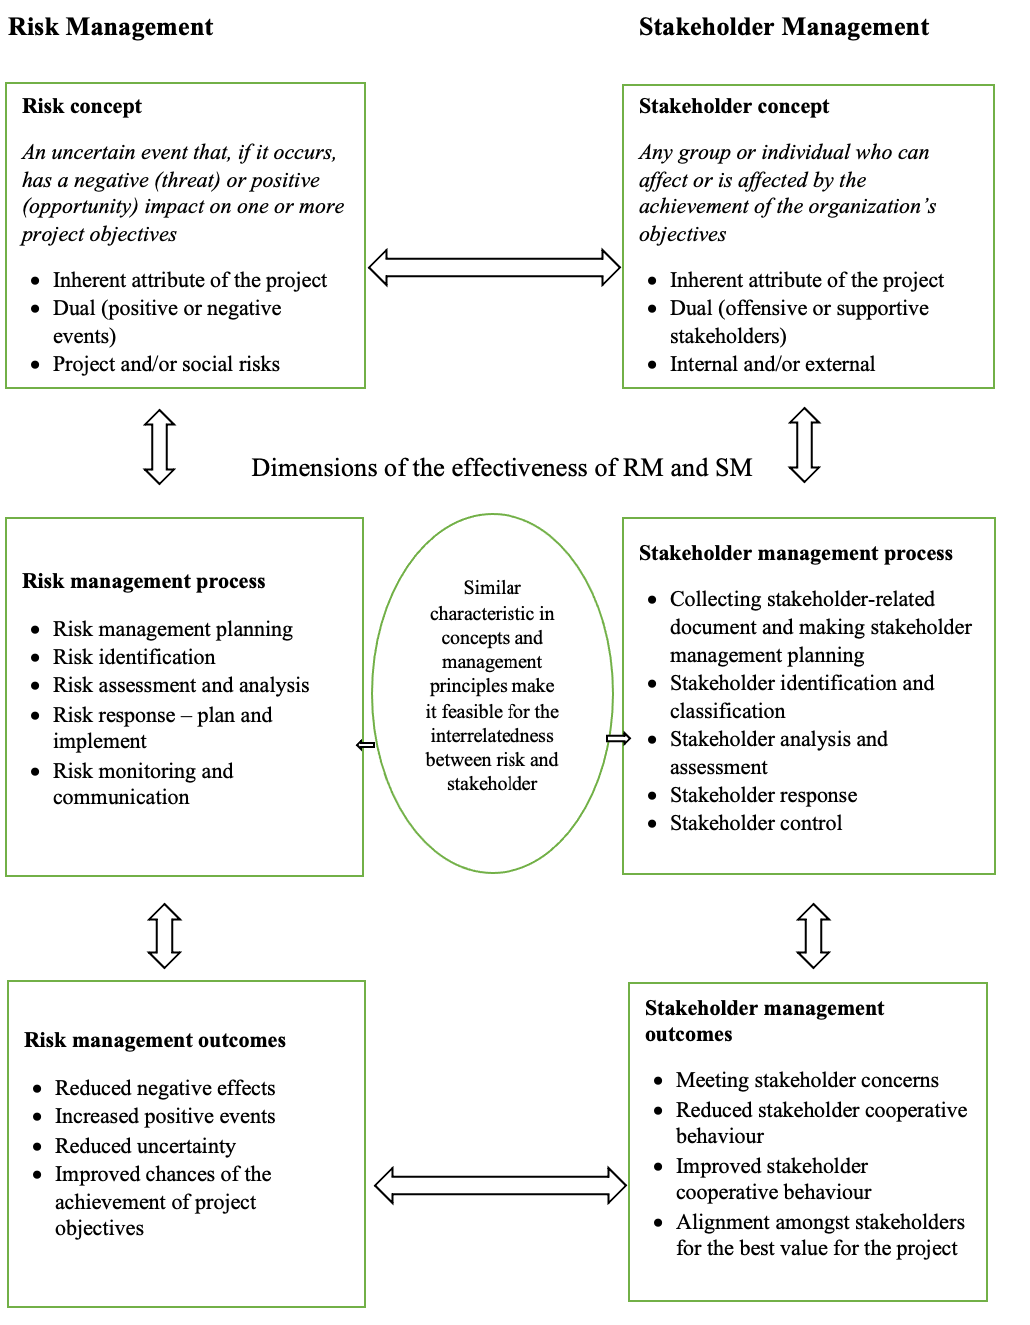
Figure 2: Conceptual framework: similarities between risk and stakeholder concepts, management processes, and outcomes. Source: N. Xia et.al.